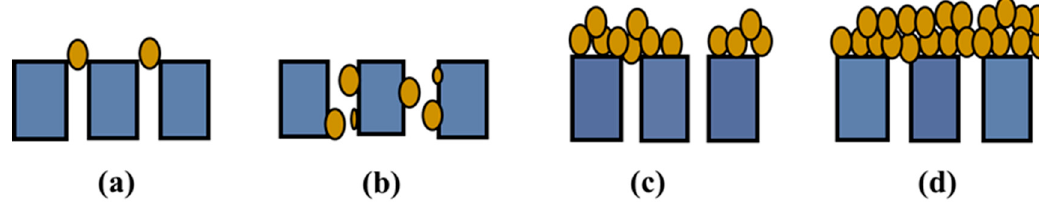
Figure 1. Illustration of the four classical filtration model: ( a ) complete blocking, ( b ) standard blocking, ( c ) intermediate blocking, and ( d ) cake filtration.